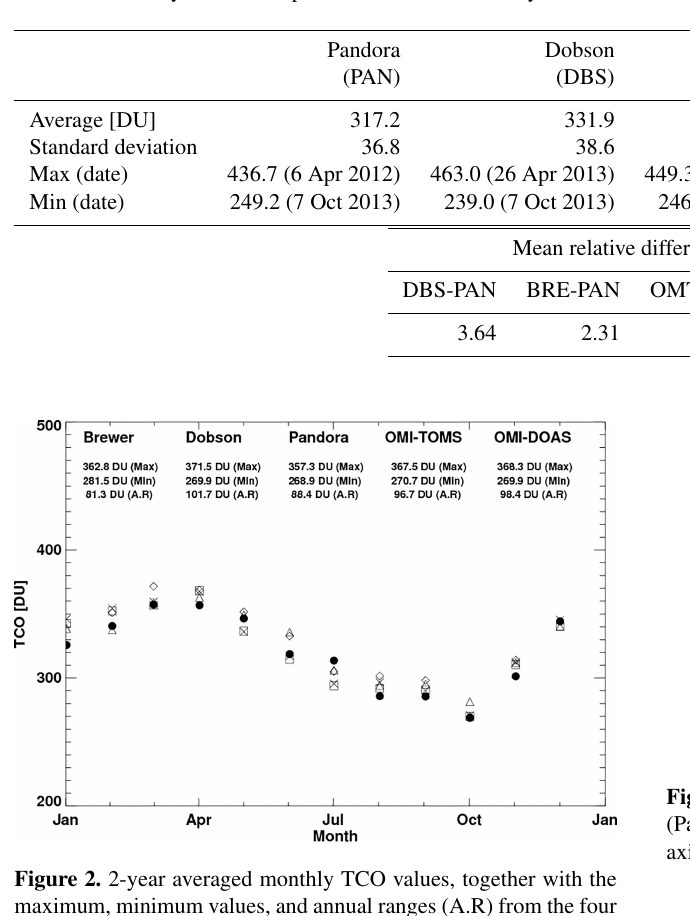
Table 2. Summary of intercomparison statistics for the 2 years from March 2012 to March 2014.